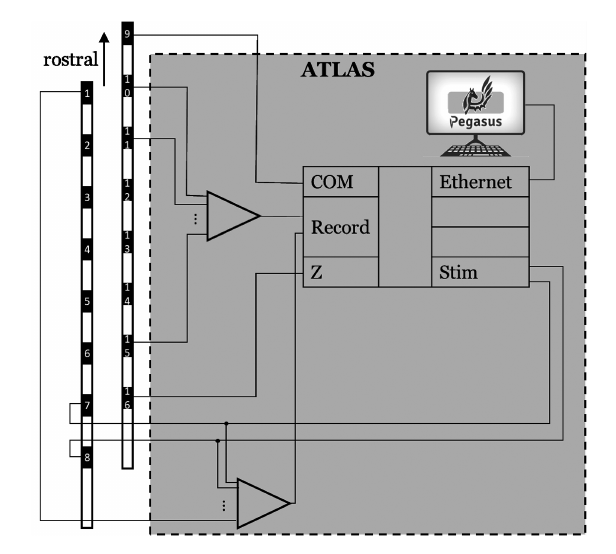
FIGURE 2 The hardware wiring featured an active ground input COM and an active ground output Z (in a hardware update, COM and Z were renamed REF and GND, respectively). The ATLAS system controlled what electrodes to be stimulated (7 and 8 in this